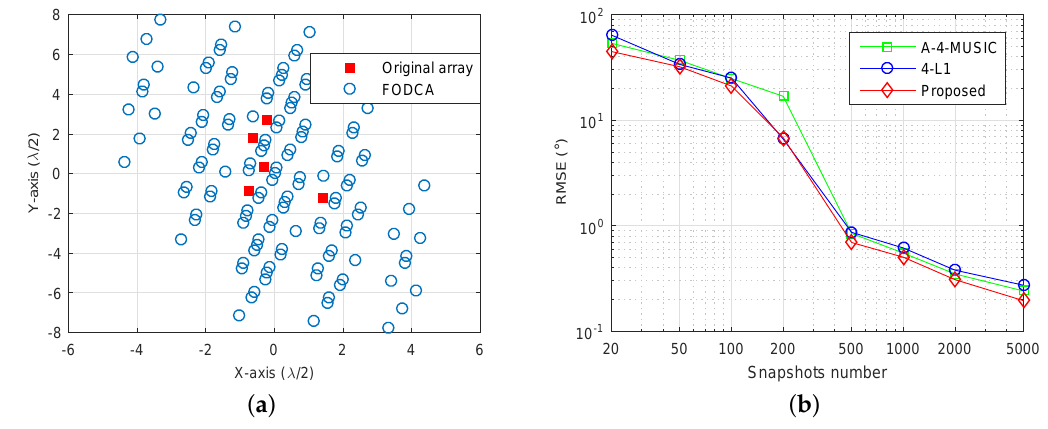
Figure 7. RMSE performance of three methods in the non-linear array case. M = 5, K = 3, r = 0.1 ◦ , ( a ) the array geometry and the corresponding FODCA geometry, ( b ) RMSE versus the number of snapshots, SNR = 6